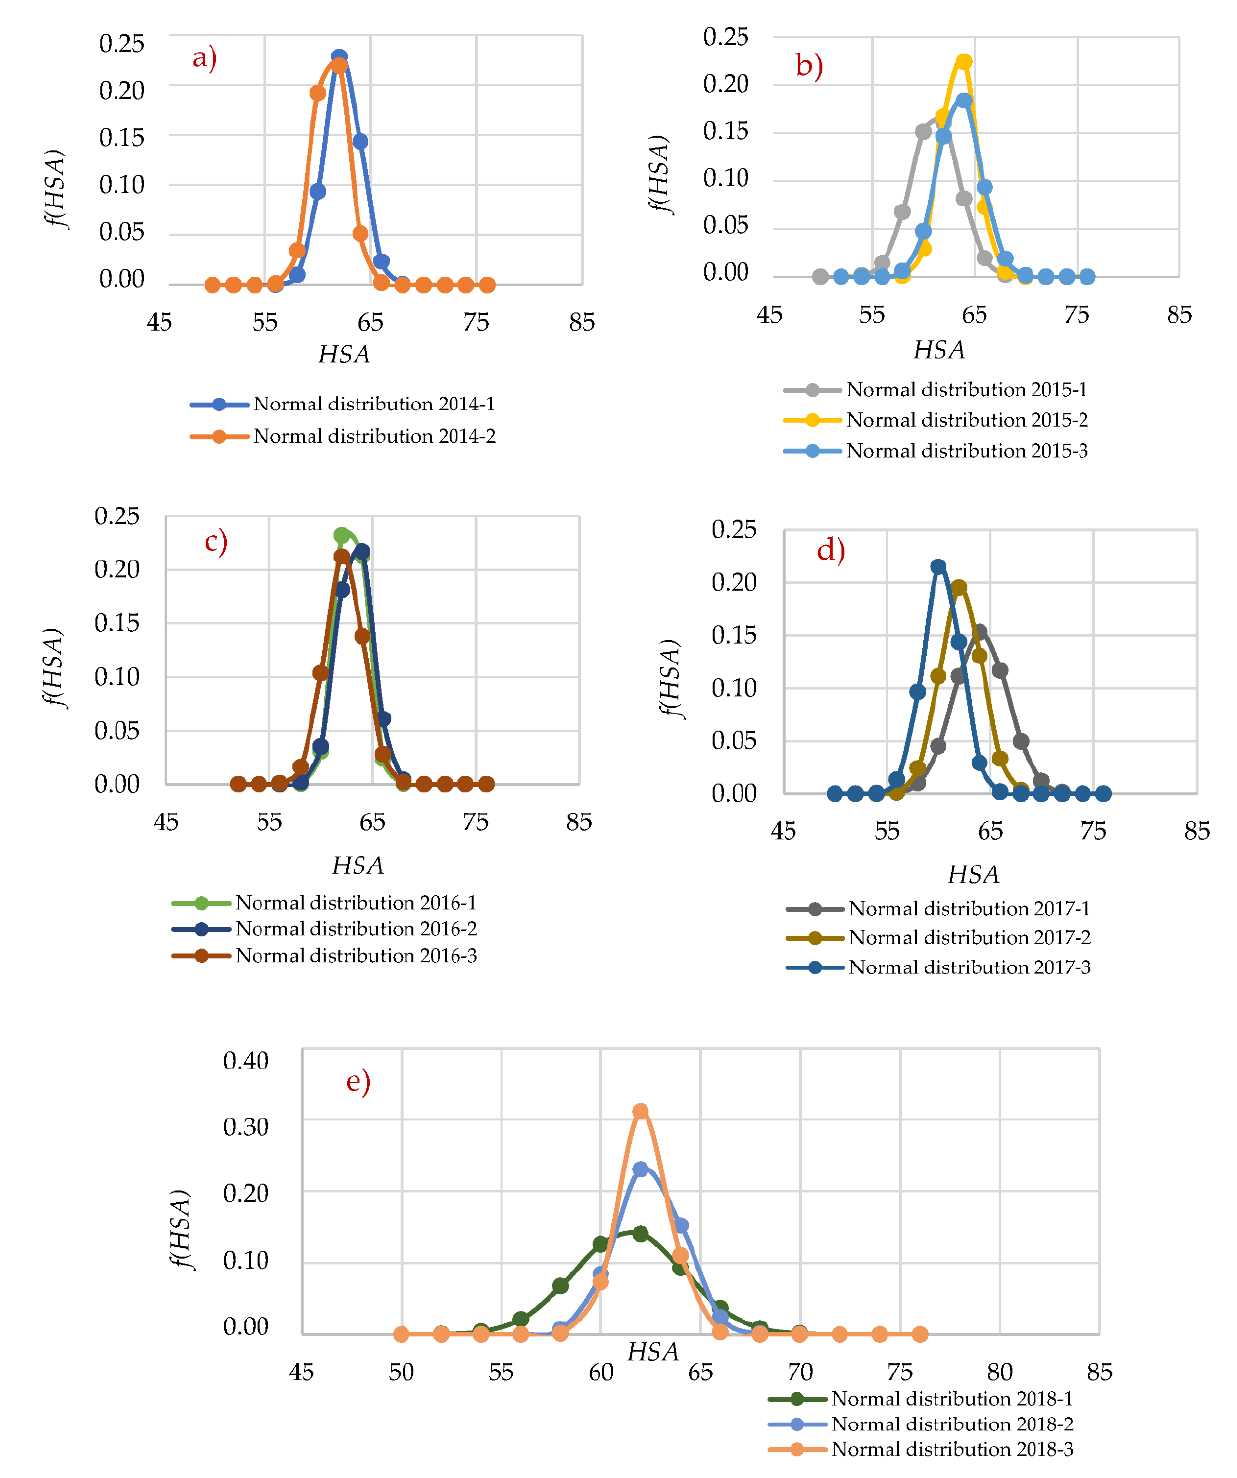
Figure 6. Normal distribution of hardness Shore A for recently manufactured O-rings. ( a ) 2014 supplies, ( b ) 2015 supplies, ( c ) 2016 supplies, ( d ) 2017 supplies, and ( e ) 2018 supplies. Table 3. Variation of every new supply hardness compared with stored ones and group standard deviation in measure- ments.